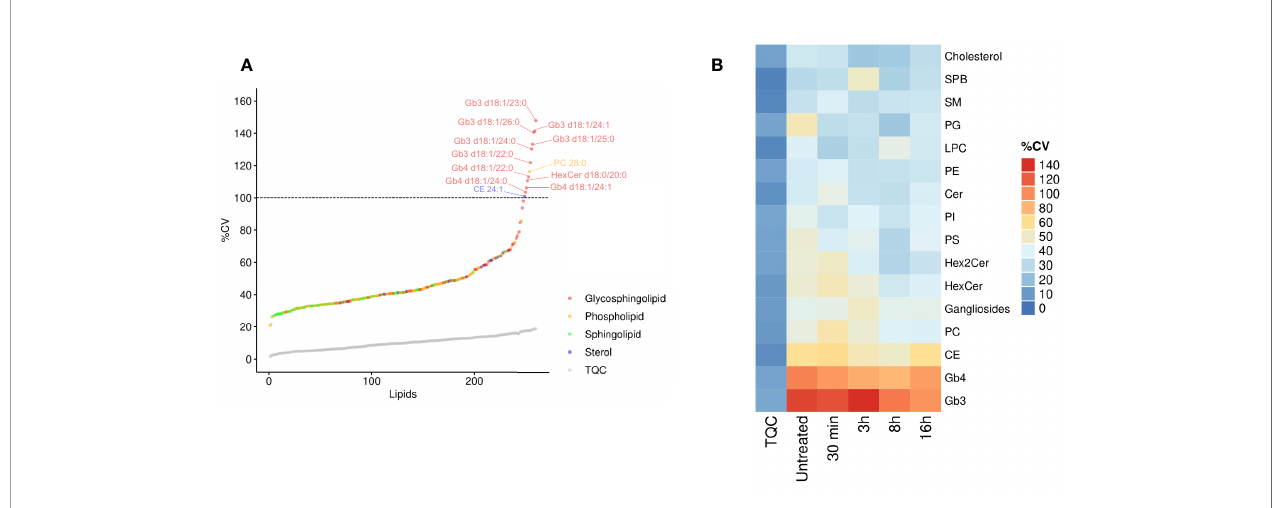
FIGURE 2 | Resolution phase lipids show high inter-individual variability. (A) The coef fi cient of variation (CV%) was calculated for each lipid for untreated hMDMs. The CV% of technical quality controls (TQC) is shown as grey circles. Dashed line represents 100% CV; Macrophages derived from N=11 donors. (B) The CV% values were calculated for each lipid class and are color coded. The fi rst column (TQC) indicates the technical variation for each lipid class. PC, phosphatidylcholines; PE, phosphatidylethanolamines; PI, phosphatidylinositol; PG, phosphatidylglycerols; PS, phosphatidylserine; LPC, lysophosphatidylcholine; Cer, ceramides; SM, sphingomyelins; HexCer, monohexosylceramides; Hex2Cer, dihexosylceramides; CE, cholesteryl esters; SPB, sphingoid bases; Gb3, globotriaosylceramide; Gb4,